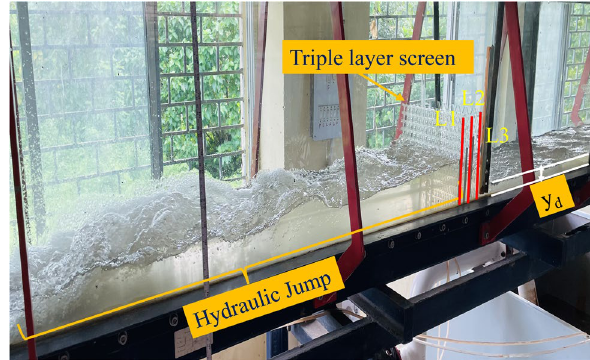
Fig. 5 Forced hydraulic jumps by the